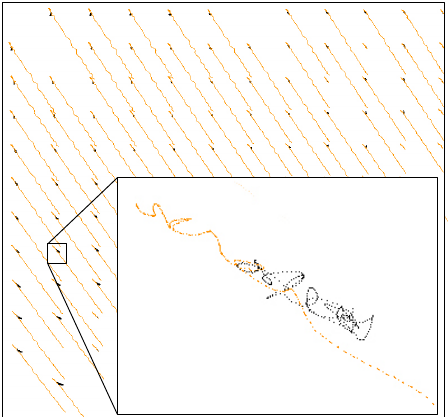
Figure 3: A set of reconstructed points (4D), in orange before and in black after the motion correction, cameras moving away from the object. The close-up figure: trajectory before motion subtraction overlaid with the corrected one; trajectories split up when cameras moved.